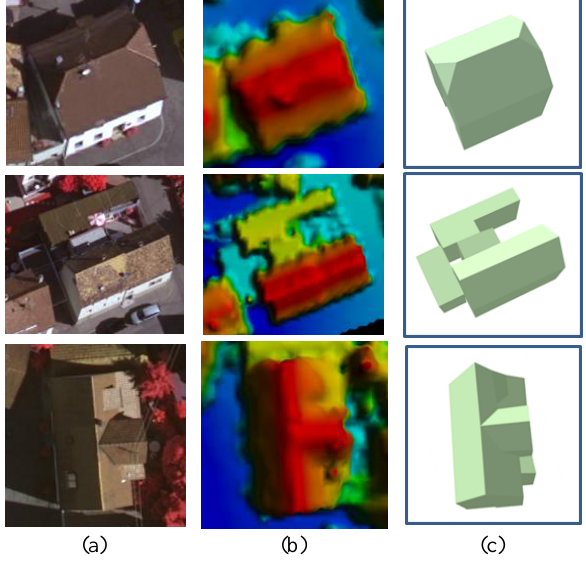
Figure 5. Reconstructed complex roof structure building: (a) airborne images, (b) Lidar point clouds, and (c) perspective view of the reconstructed 3D building model.